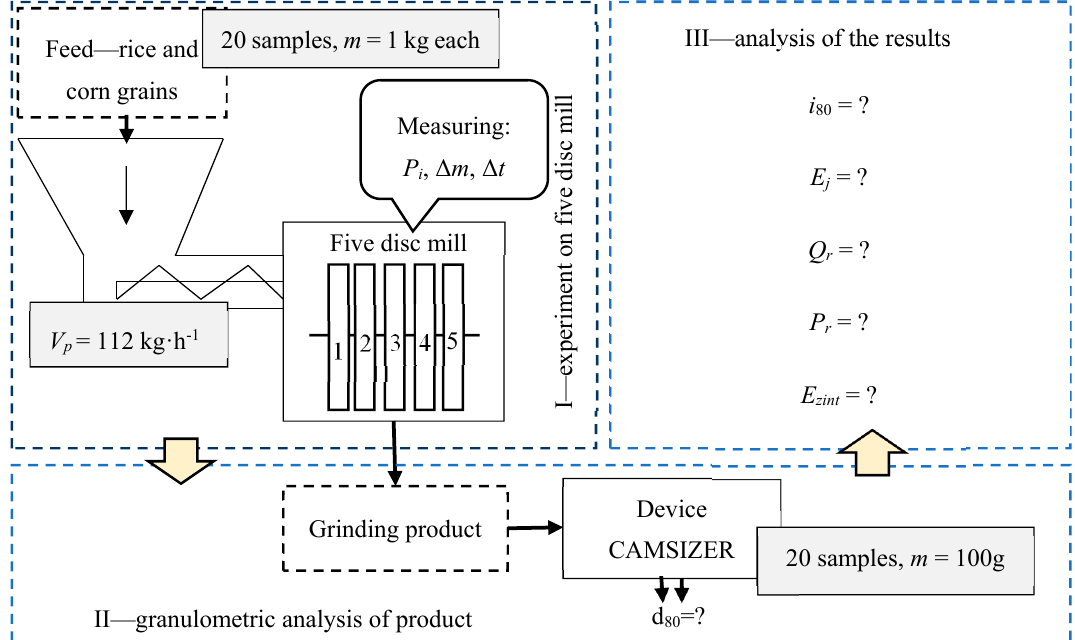
Figure 3. Research plan. V p —feed dosing capacity, P i —power consumption on the i -th disc, ∆ m —mass increase in the intake hopper, d 80 —dimension of the sieve hole through which 80% of the grinding product passes, i 80 —80% fragmentation degree, E j —unit energy consumption, Q r —yield of grinding, P r —power consumed by the grinder, and E zint —integrated energy consumption.